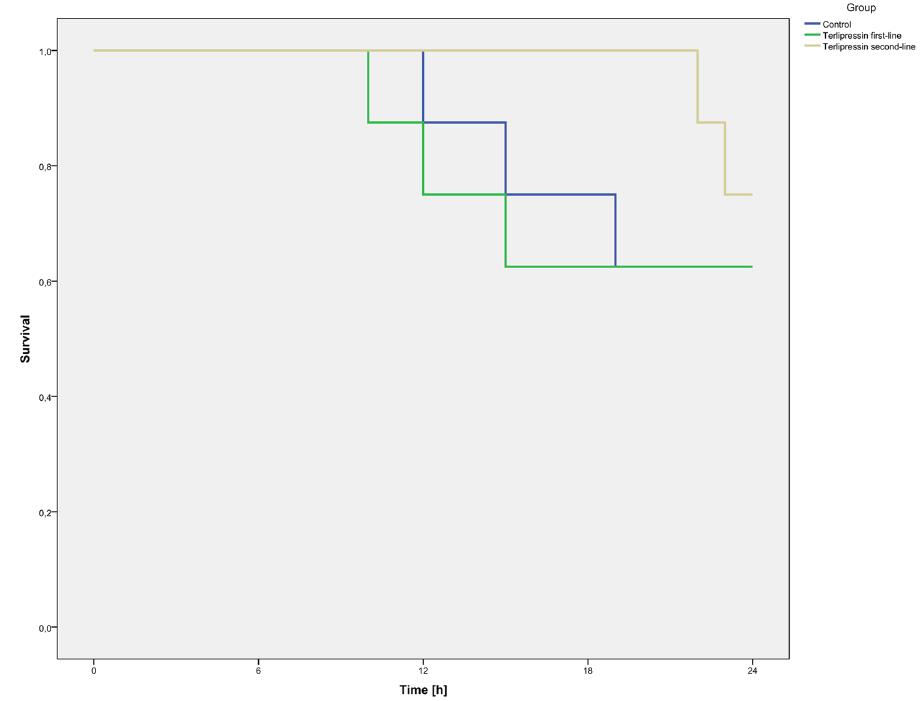
Figure 5. Survival of the study animals. The figure illustrates survival of the study animals over the 24-hour interventional period in a Kaplan-Meyer